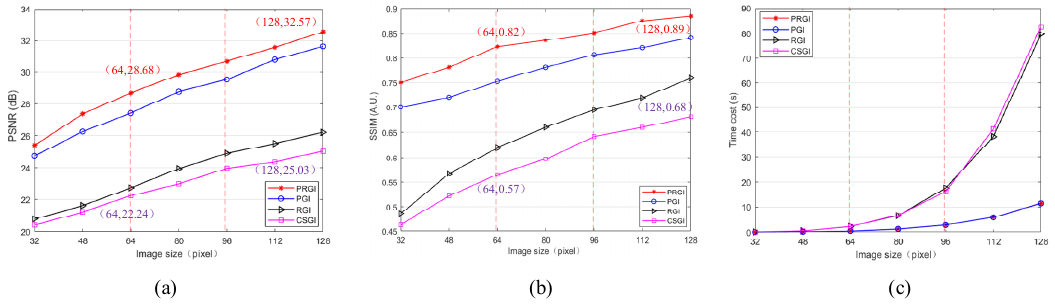
Figure 6. Quantitative analysis results of ‘CSGI’, ‘PGI’, ‘RGI’ and ‘PRGI’ under different image sizes. ( a ) PSNR; ( b ) SSIM; ( c ) Time cost. Table 1. Time cost(s) of the four methods under different image sizes. Image Size 32 × 32